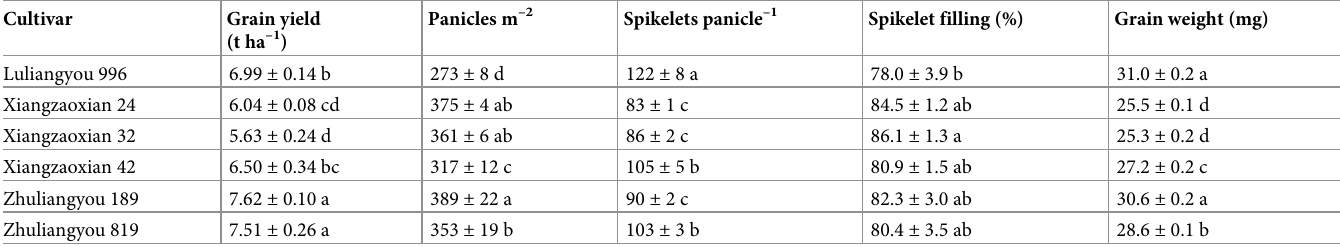
Table 1. Grain yield and yield components of six early-season rice cultivars.